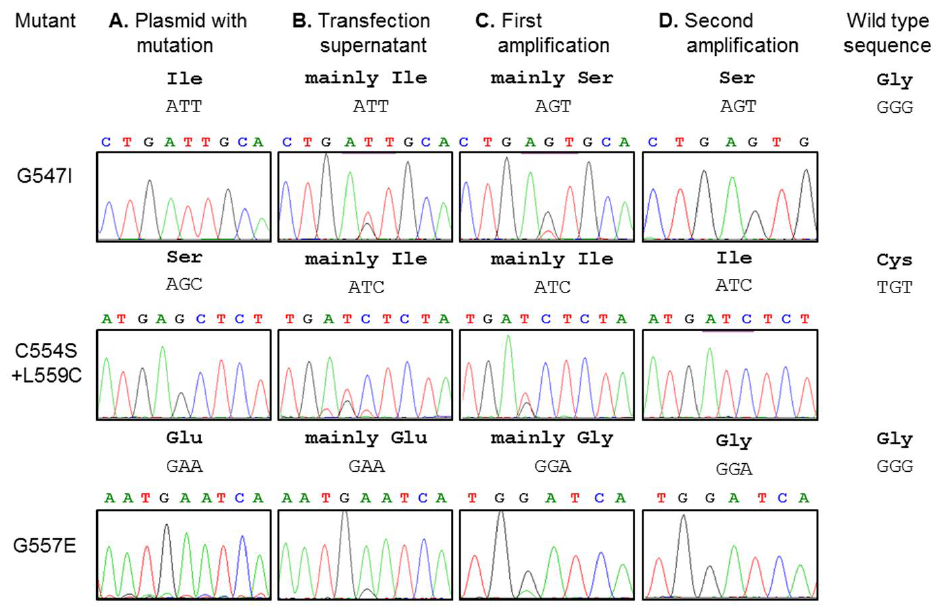
Figure 2. Observed reversions in codons of the mutants G547I, Ac1 + L559C and G557E. ( A ) Sequencing chromatograms of plasmids after site-specific mutagenesis and before transfection into 293T cells; ( B ) Sequencing chromatograms obtained from virus particles three days after transfection of 293T cells; ( C ) Sequencing chromatograms obtained from virus particles propagated at an m.o.i. of 0.1 one day after infection of MDCK cells; ( D ) DNA sequence after a second propagation of the virus in MDCK cells. After 24 h the supernatants were collected, the viral RNA was isolated and subjected to RT-PCR and sequencing. Sequence of the mutated codon, the specified amino acid as well as the respective information for wild type HA is indicated. The reversion of G547I to G547S was always observed (five attempts). Thus, we were not able to obtain stable virus particles with an isoleucine at position 547. Reversion of C554S (Ac1) + L559C to C554I + L559C occurred three times